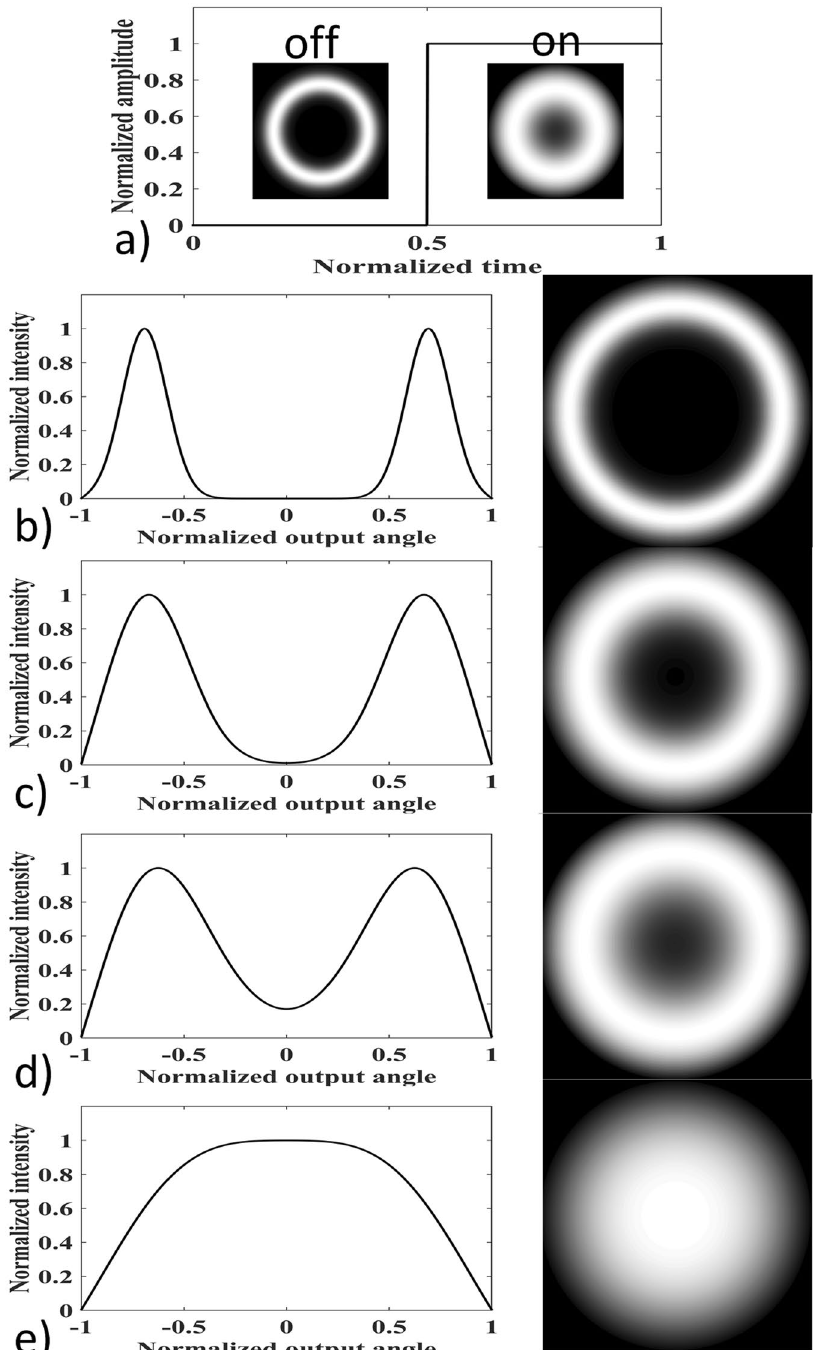
Figure 4. Simulation results of tuning doughnut beam profiles through perturbations applied on a large core MMF. ( a ) shows the schematic diagram of the simulation for doughnut profile tuning using square-wave perturbation. During perturbation On, more power flowed into the center of the doughnut. ( b , c , d and e ) show the doughnut and its associated intensity profiles when different amplitudes of perturbations were